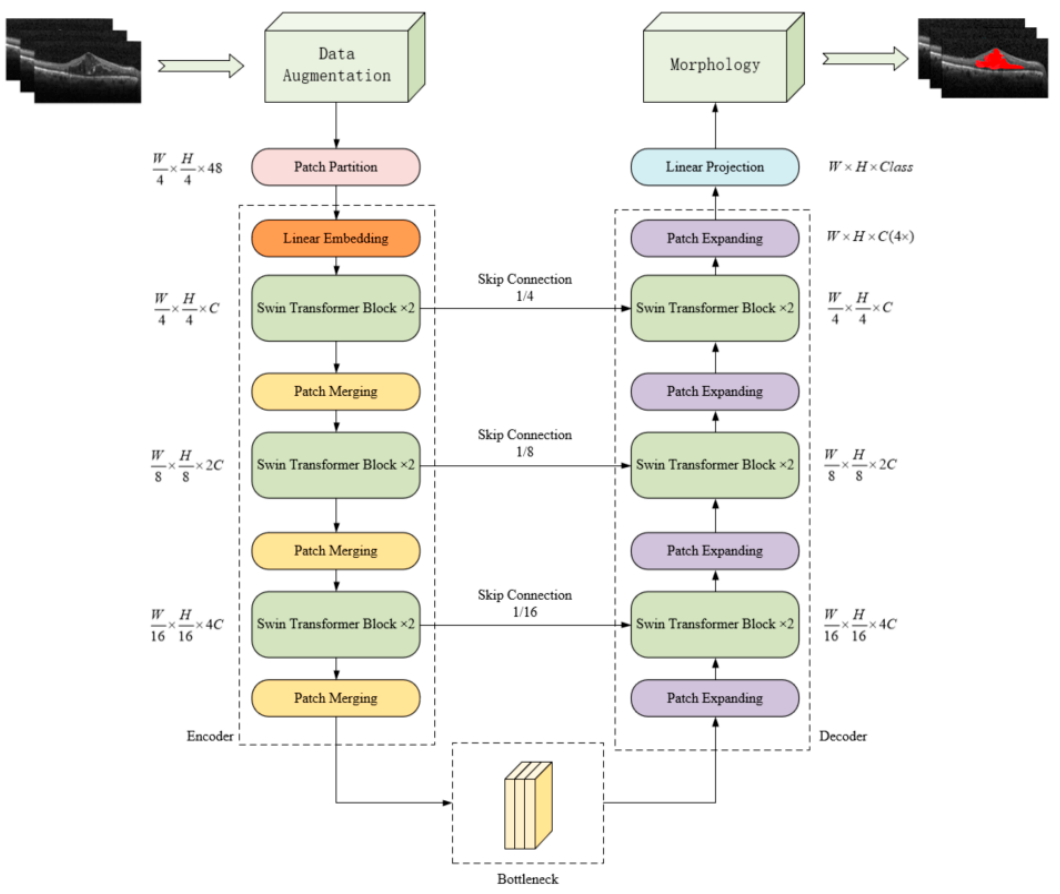
Figure 2. Flow chart of the proposed method.